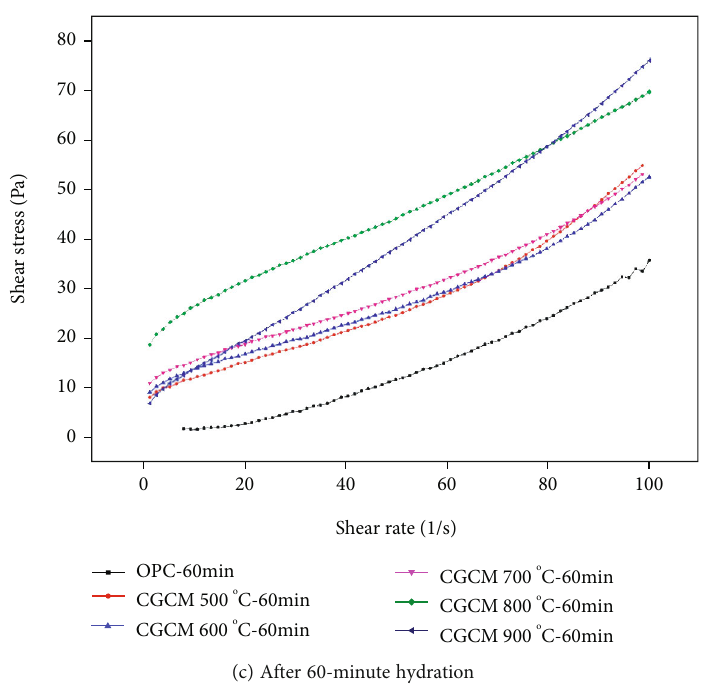
Figure 4: Time-varying shear stress curve of fresh slurry mixed with heated-activated coal